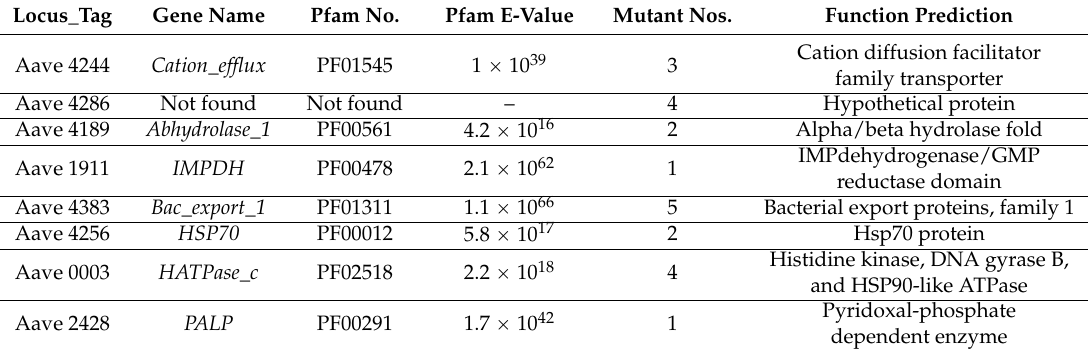
Table 2. Identification of Tn5 transposon insertion sites by hiTAIL-PCR with BLAST and functional prediction by Pfam 28.0 (May,